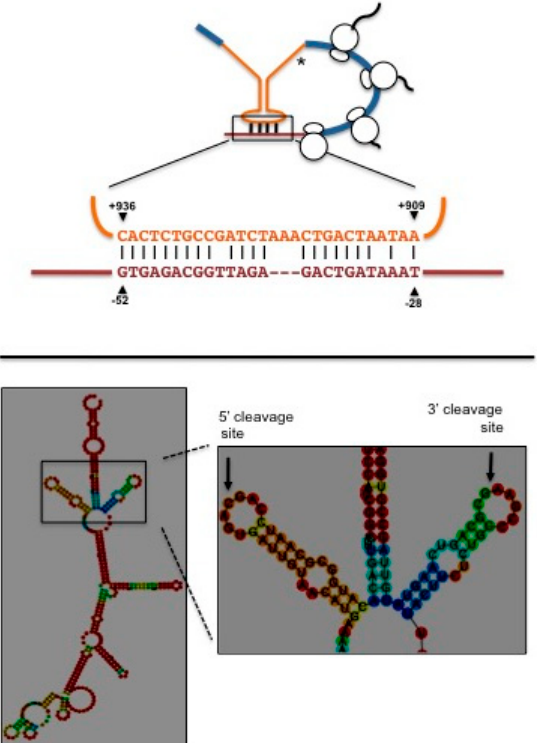
Figure 6. ( Top ) Diagram of a predicted translation attenuation structure formed in the K. lactis HAC1 pre-mRNA. Exons are indicated in blue, intron is indicated in orange and 5 ′ untranslated region in brown. Coordinates are relative to the first nucleotide of the translation start codon. Asterisk indicates an in-frame stop codon located within the intron. ( Bottom ) Predicted stem-loop secondary structure of the exon-intron boundaries of K. lactis HAC1 pre-mRNA. Arrows pinpoint the 5 ′ and 3 ′ cleavage sites. The predicted secondary structure was obtained using the RNAfold web server from the ViennaRNA Web Services.